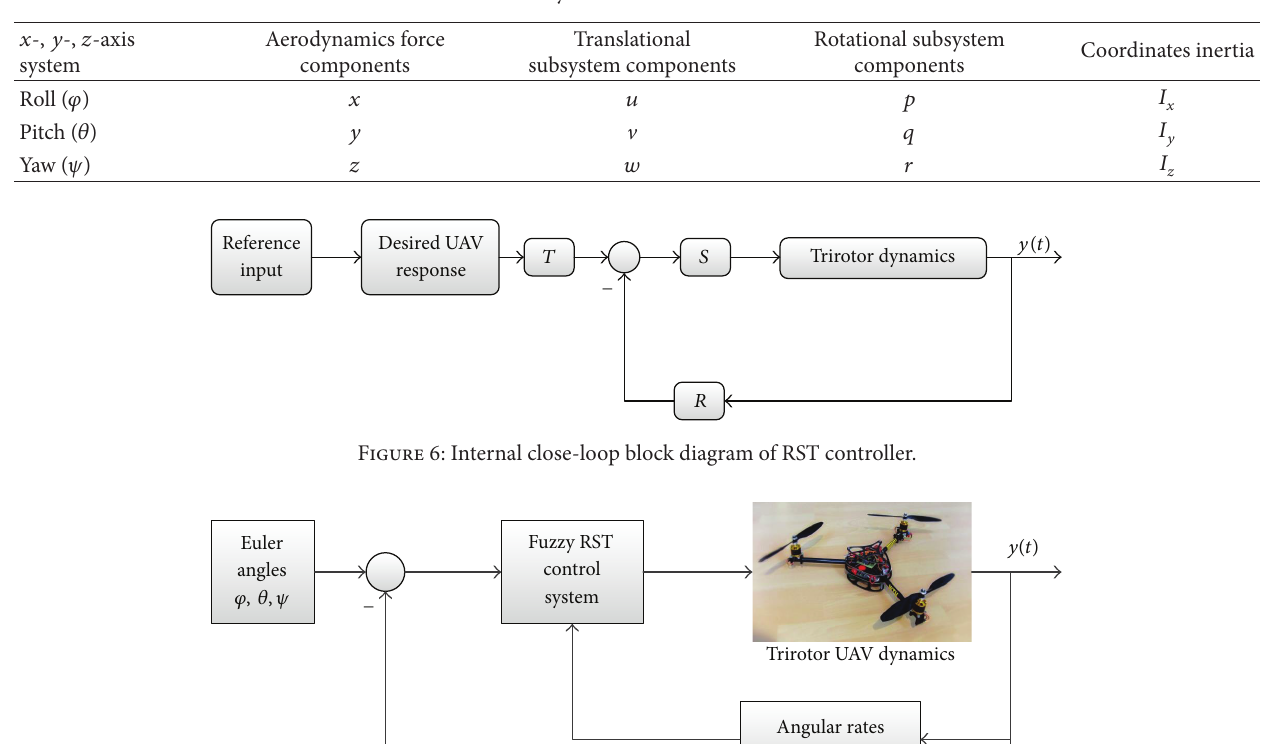
Table 1: Dynamics & constants of UAV.